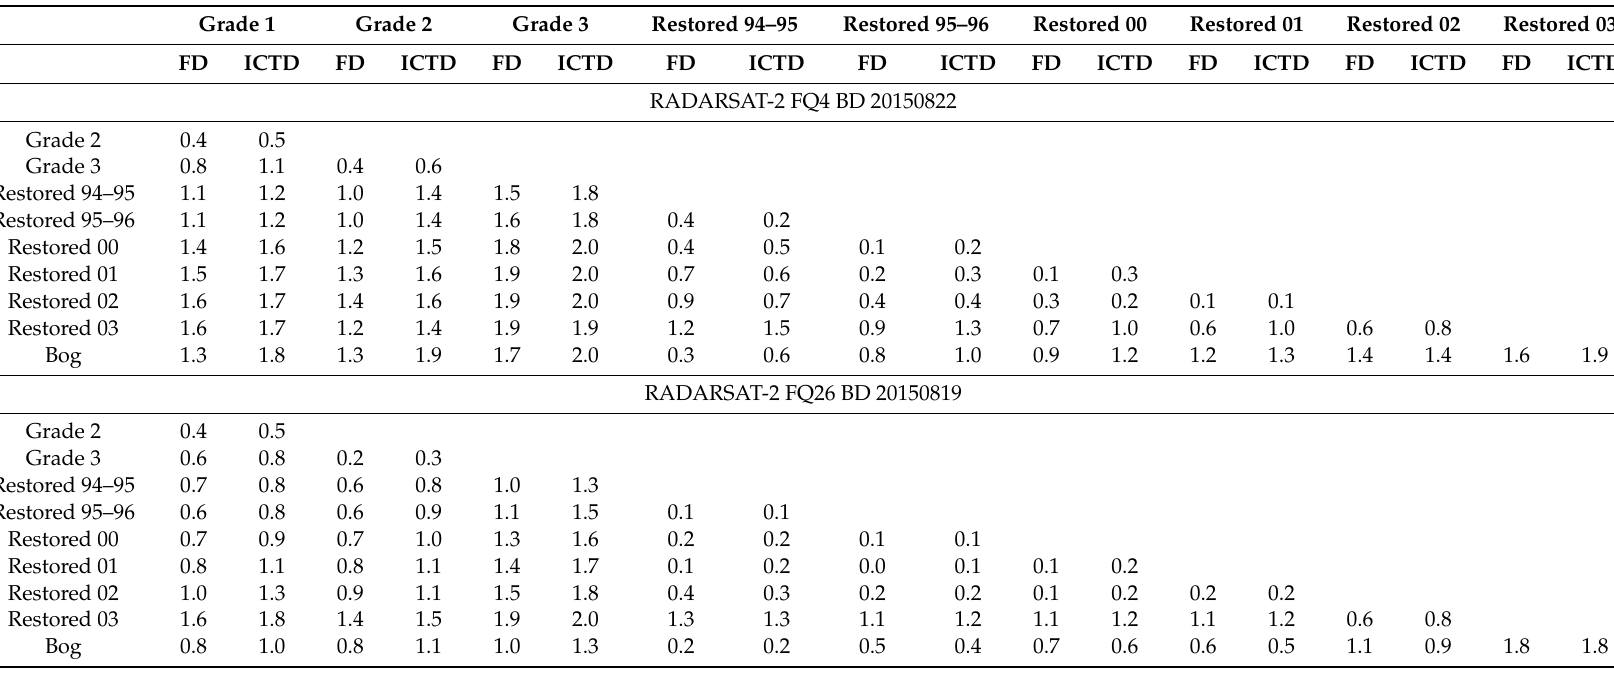
Table 3. Values represent the Bhattacharya distance (BD) statistic for the RADARSAT-2 FQ4 22 August 2015, and FQ26 19 August 2015 images. This metric was used to determine whether the spectral responses of natural shrub bog, restored peat, and actively harvested peat can be separated. Values equal to or greater than 1.9 indicate good spectral separability and values below 1.9 indicate poor